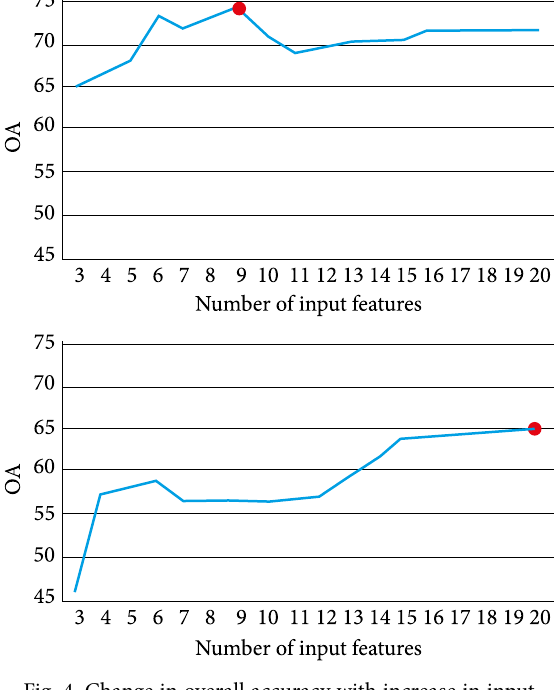
Fig. 4. Change in overall accuracy with increase in input feature number for PCA-FLL (a) and DBFE-SAM (b) feature extraction-classifier ensemble (effective feature number in each case is marked by